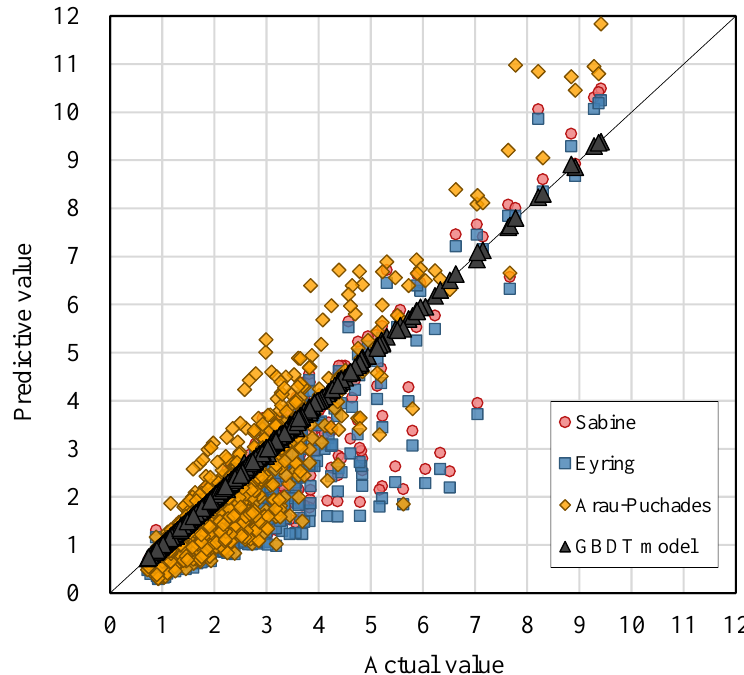
Figure 21. Scatter plot of reverberation time. Table 11. The RMSE of reverberation time for 800 spaces.